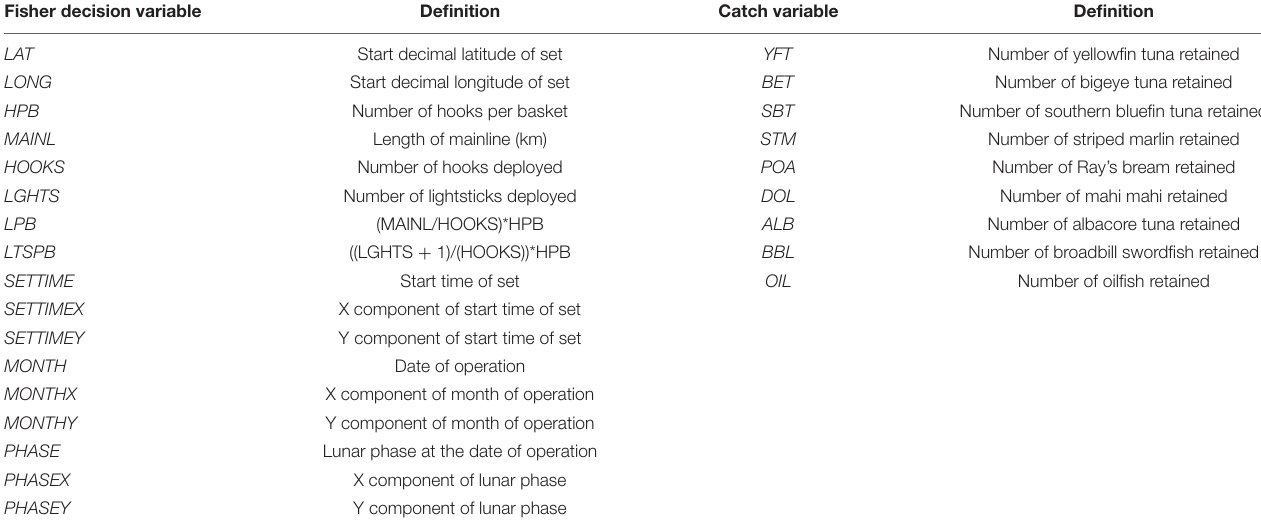
TABLE 1 | The set of 26 fisher decision and catch variables that were derived from the ETBF logbook data for the métier analysis and their corresponding definition. Fisher decision